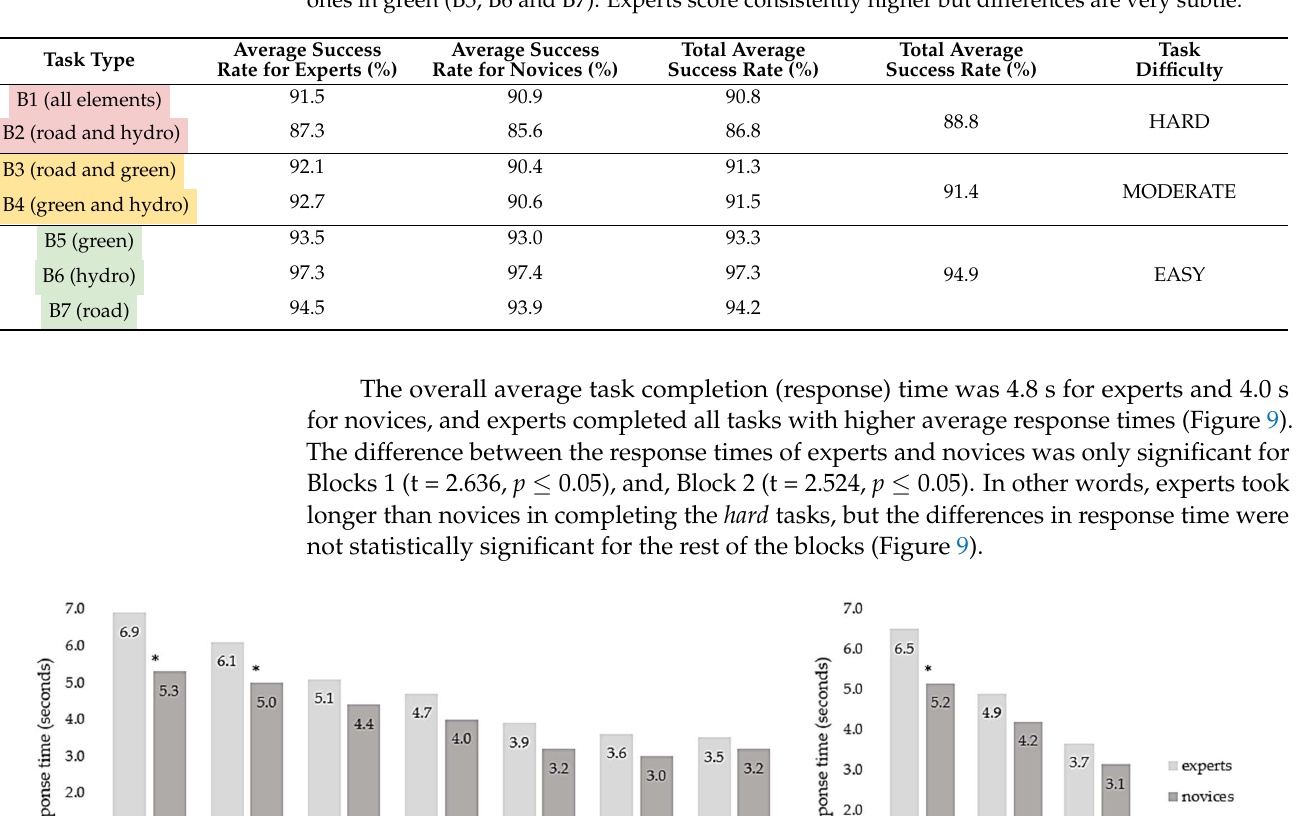
Table 4. Average success rates (%) of experts and novices per task type and task difficulty. Objectively hard tasks marked with red highlight (B1 and B2), moderate in orange/yellow (B3 and B4) and easy ones in green (B5, B6 and B7). Experts score consistently higher but differences are very subtle.